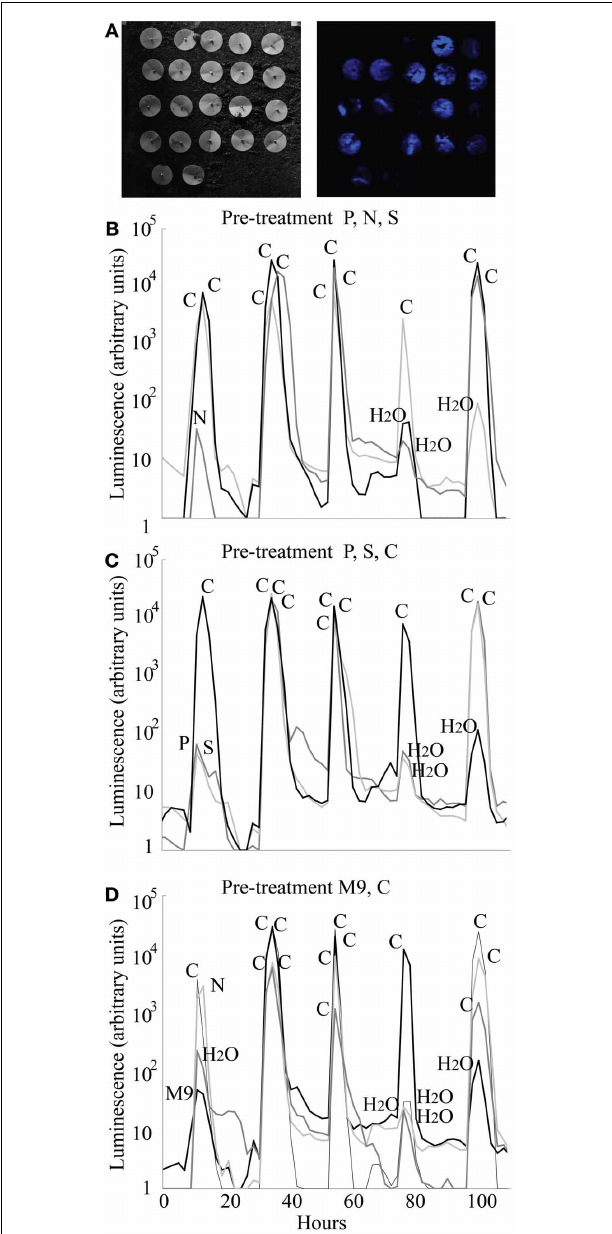
FIGURE 7 | Luminescence detected using a Versarray CCD camera from populations of microbiosensor KT2440/pZKH2 inoculated onto soil and provided with pulses of carbon, various mineral nutrients, and water, all delivered via filter discs pinned to the soil surface. Panel (A) shows brightfield (left) and false-color luminescence (right) images of the filters. Panels (B,C,D) show luminescence from replicate filter discs within three of seven pre-treatments (see text), over five days, as pulses of carbon, nutrients, and water were